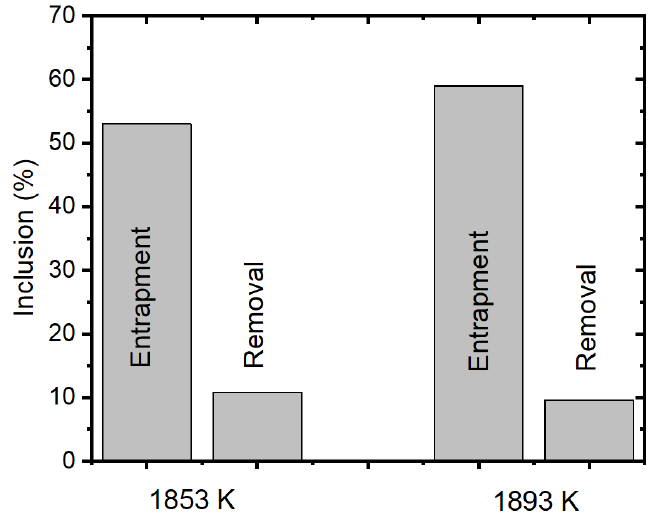
Figure 17. Entrapment and removal (from outlet) percentages of alumina inclusion.